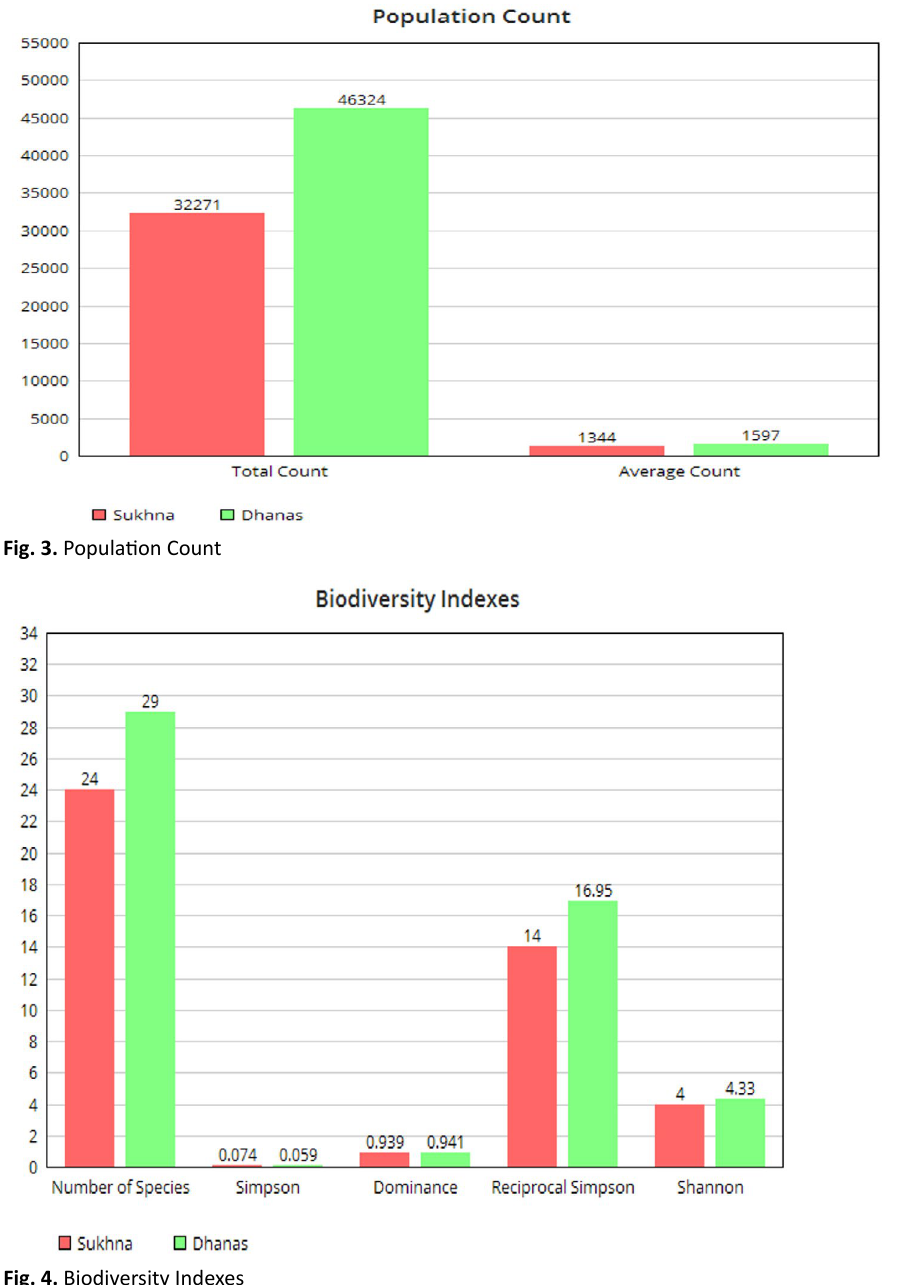
Fig. 4. Biodiversity